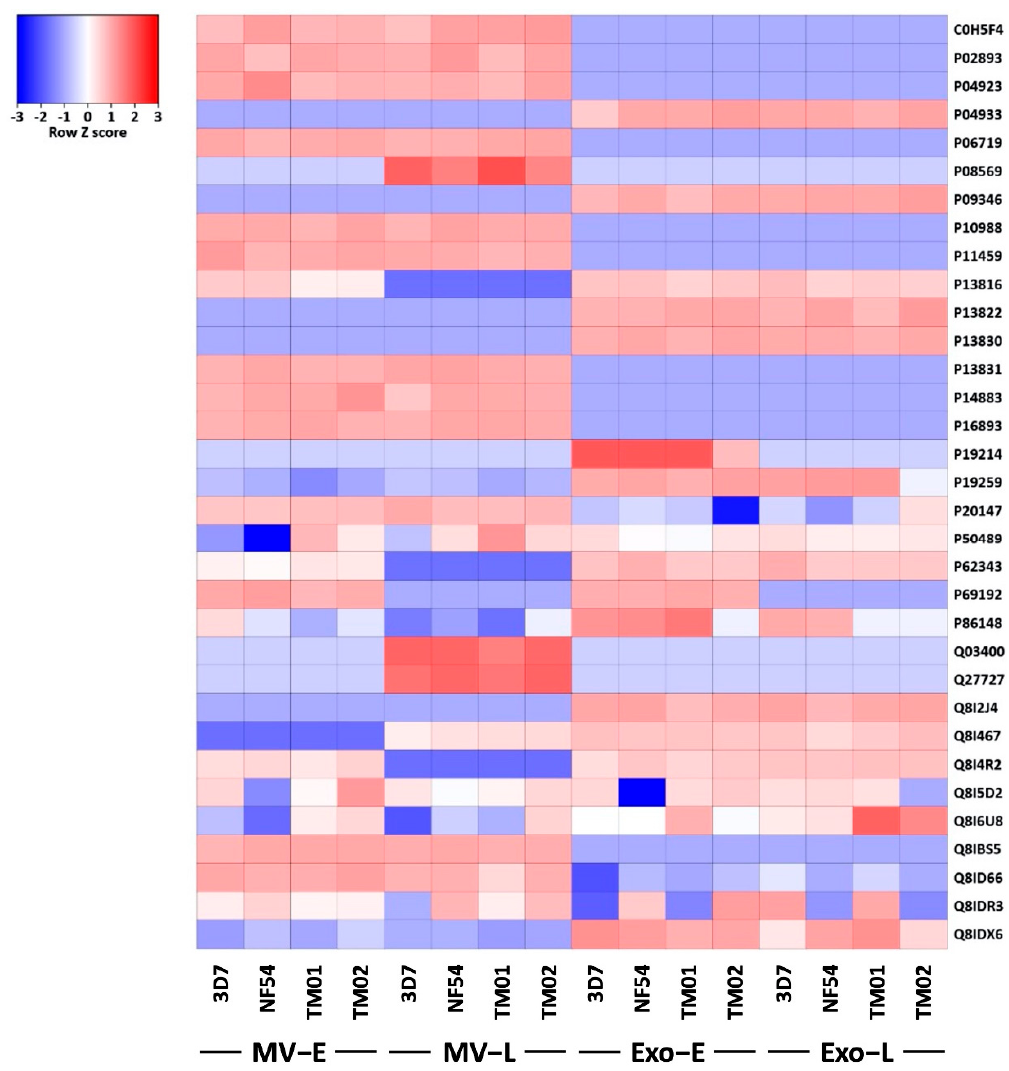
Figure 6. Heatmap of differential expression levels of invasion associated P. falciparum proteins detected in Pf -EVs. Side bar indicates differential protein expression between each sample (blue: decrease, red: increase). Rows: proteins; columns: samples.